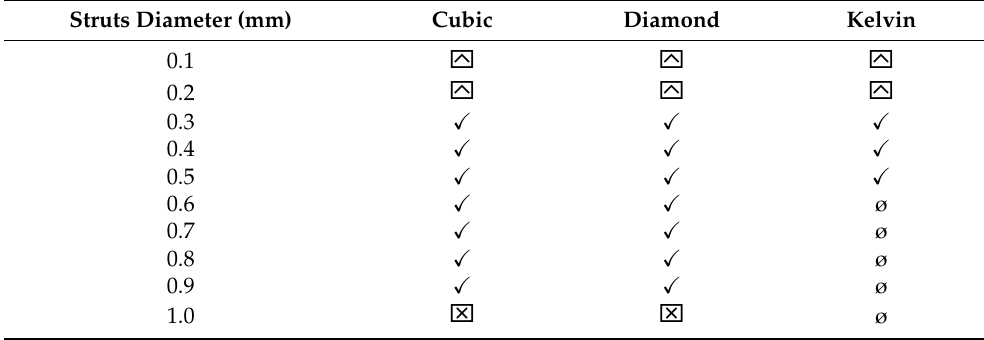
Table 1. Summary of problems observed before and after the printing of the parts.